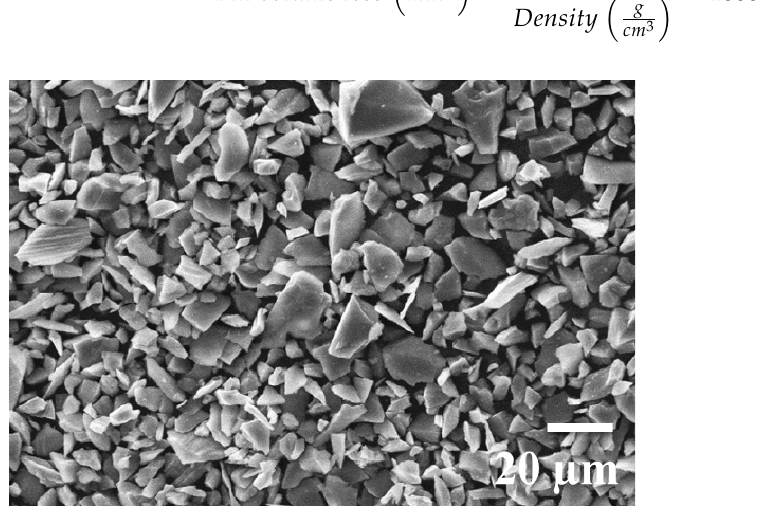
Figure 1. SEM micrograph of SiC p reinforcement